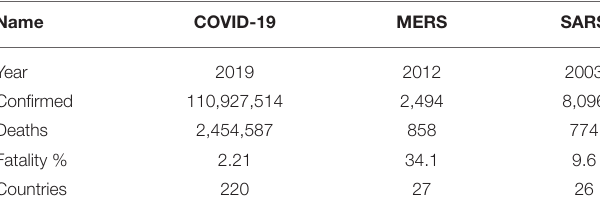
TABLE 2 | Top 5 affected countries COVID-19